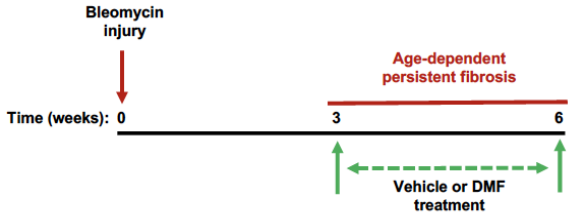
Figure 2. Aged-injured mice exhibit Nrf2 deficiency associated with oxidative stress and lung fibro- sis. ( A , B ) Lung protein was assessed for Nrf2 expression by Western blot ( A ) and densitometric analysis ( B ). ( C ) The level of lung oxidized glutathione was analyzed by quantitative oxidized glu- tathione assay. ( D – G ) Lung protein was assessed for fibronectin ( D , E ) and collagen-1 α (Col-1 α ) ( F , G ) expression by Western blot and densitometric analysis. Representative Western blot images are shown. All values represent means of biological replicates ± SEM; n = 4 mice per group; * p < 0.05; ** p < 0.01 using Student’s two -tailed t -test.